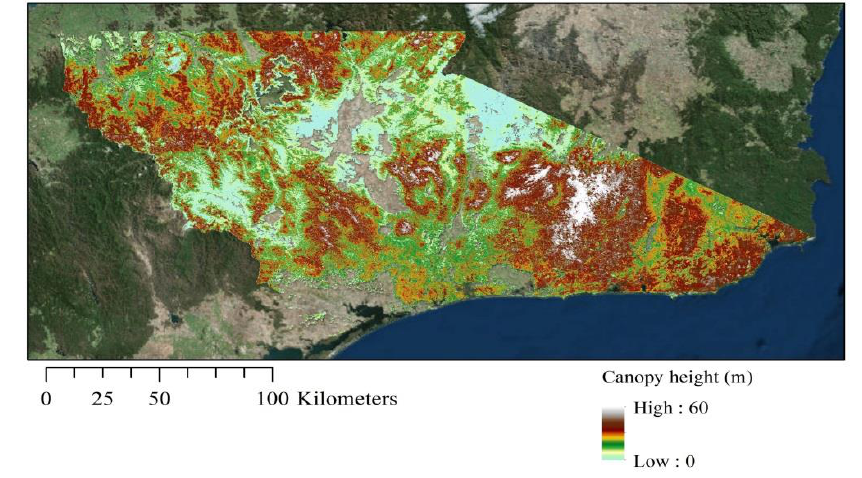
Figure 1. Canopy height derived from Landsat and MODIS satellite imagery using ensemble regression tree